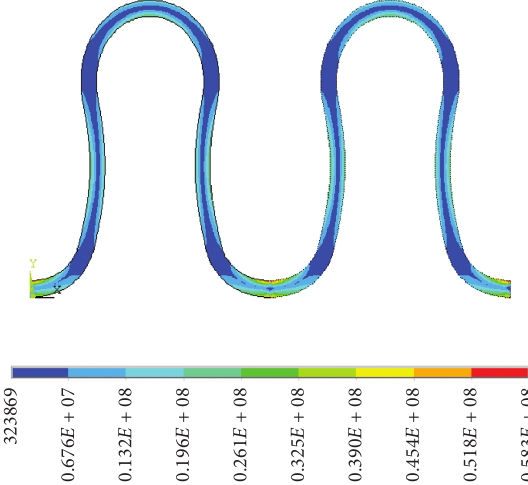
Figure 4: Stress distribution at air outlet and gas inlet side without considering thermal stress